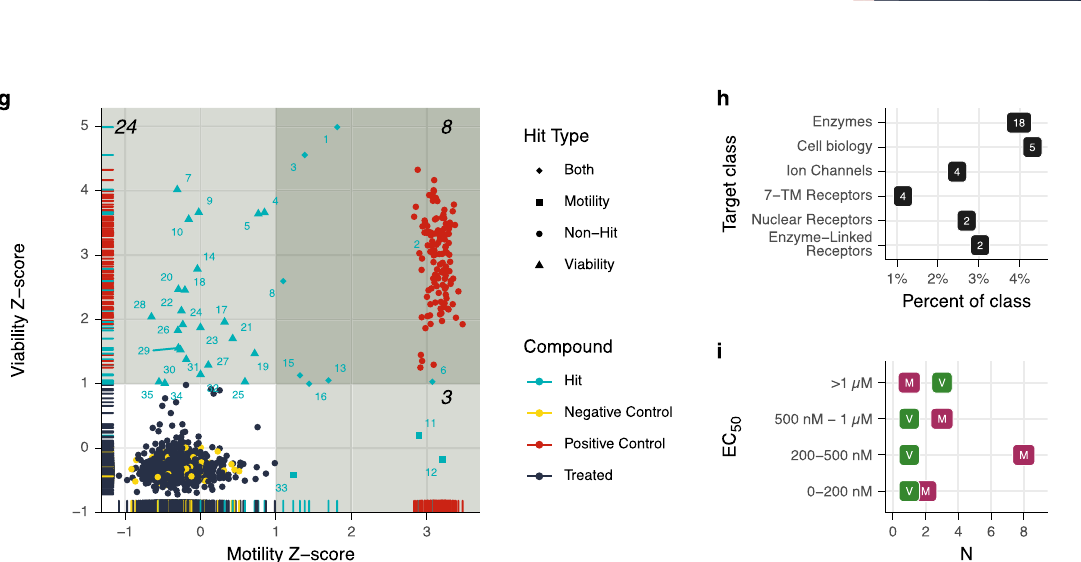
screen reproduced effects in the dose-response experiment, while 2/3 and 7/19 of the motility and viability hits were reproduced, respectively. Thirteen of the hits had EC 50 values of <1 µM for at least one phenotype, and ten of these were <500 nM (Fig. 2i). Two hits had an EC 50 of less than 100 nM: NSC 319726, a p53 reactivator (19 nM) and NAV 2729, an Arf6 inhibitor (81 nM).